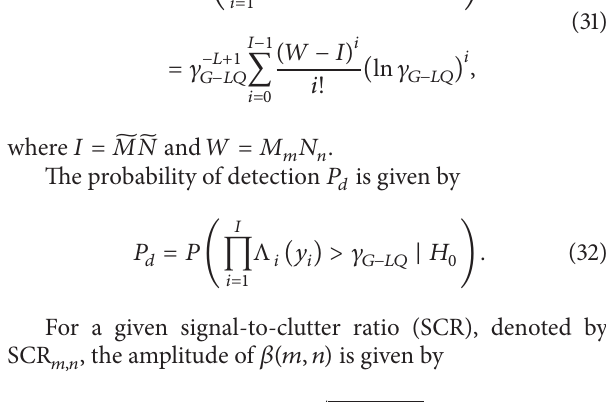
Figure 3: GLRT-LQ detector performance in low-grazing angle.